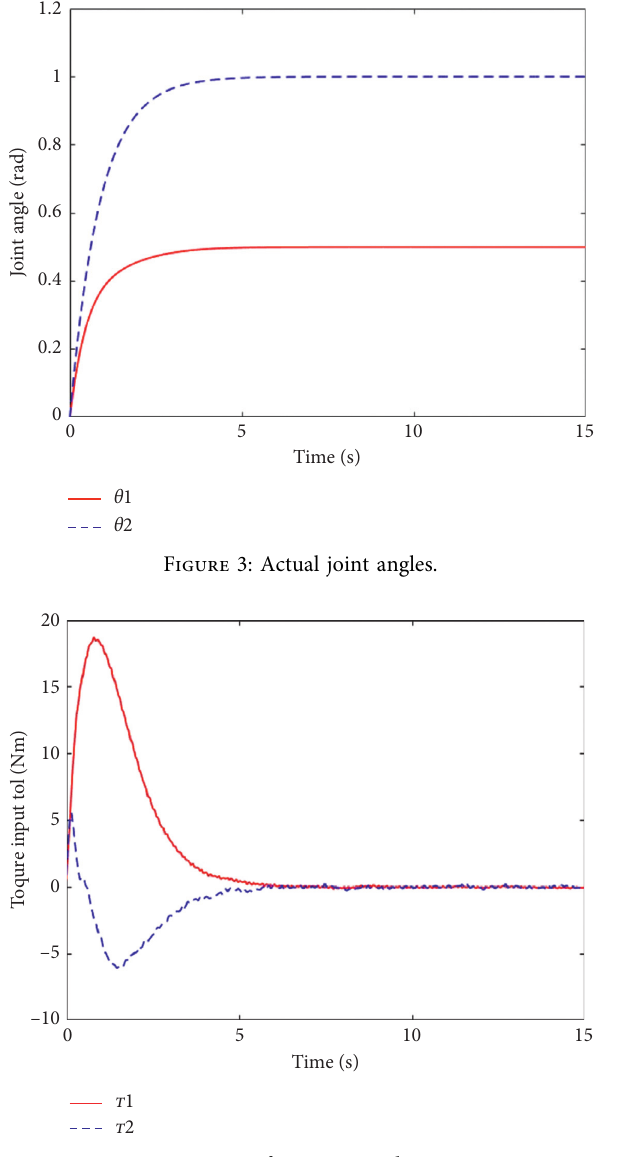
Figure 4: Uncertain function a and its estimate s .